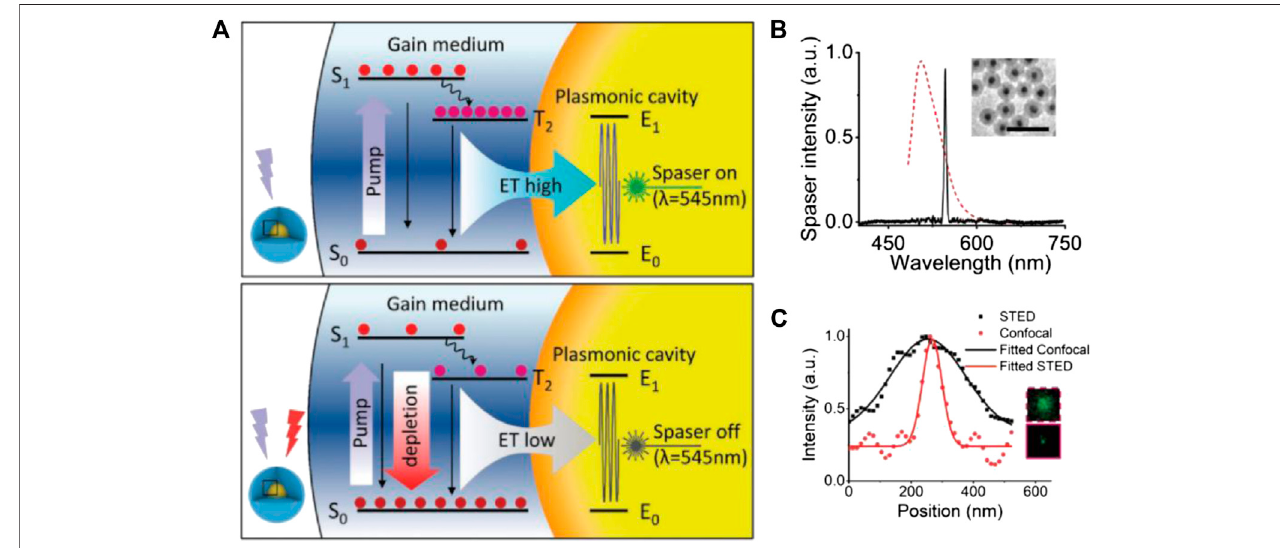
FIGURE 11 | STED performance of spaser nanoprobe (Gao et al., 2020). (A) The energy diagram of spaser in STED; notice that the energy of STED light is higher than the spontaneousemission energy. (B) Typical emission spectra of spaser (black solid) and the originaldye (red dotted). (C) Resolution enhancement from confocal to STED imaging and the corresponding plot fi les.